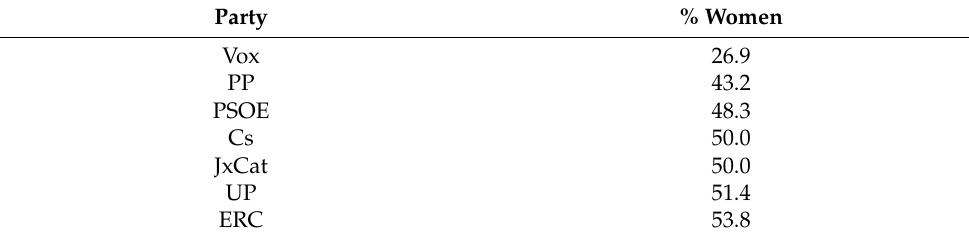
Table 1. Percentage of women in Spanish Congress in 2019 per party